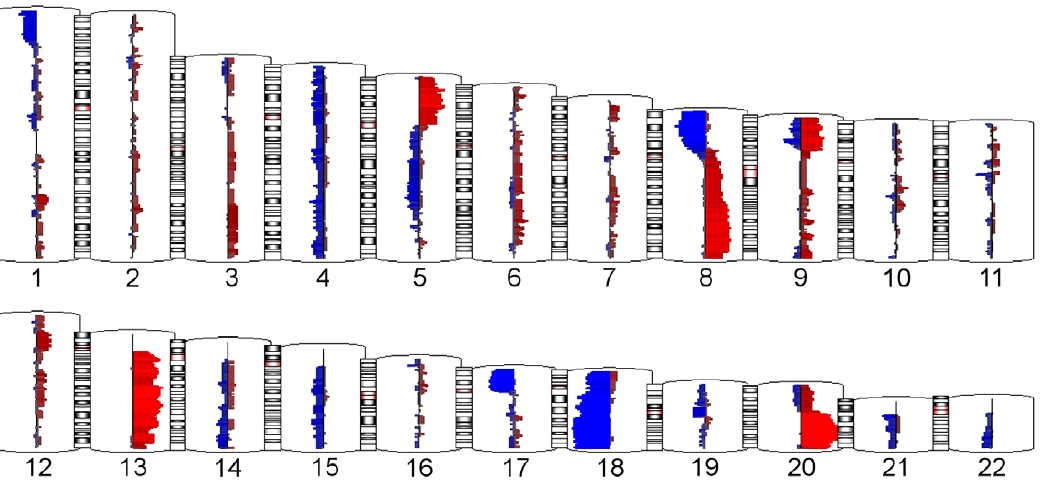
Figure 1. Amplified/deleteted regions observed in this study’s CRC tissue samples. Amplifications (mean CN $ 2.5) are shown in red, and deletions (mean CN # 1.5) are shown in blue. The horizontal size of the bar representation how many samples (at least 9 samples, 10%) exhibited the amplification/deletion. doi:10.1371/journal.pone.0031968.g001 PLoS ONE |